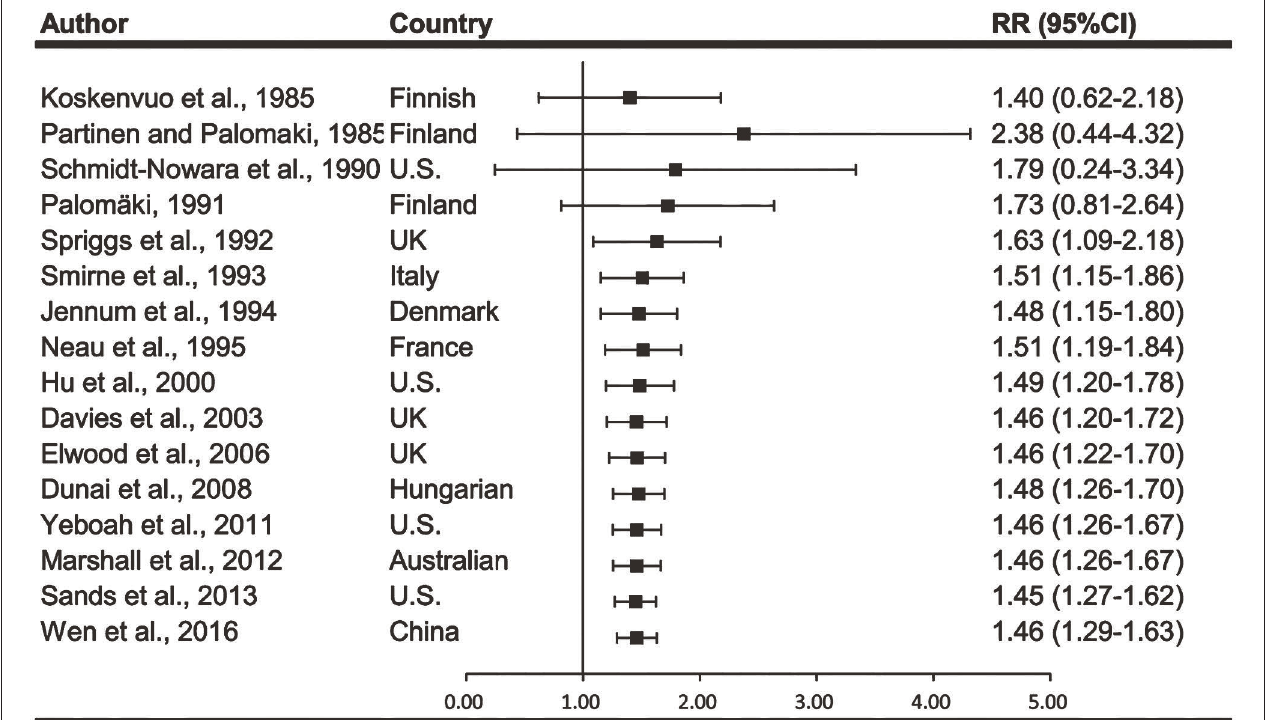
FIGURE 2 | Cumulative meta-analysis describing the association between snoring and risk of stroke. The results indicated there is a consistent association after the initial discovery.